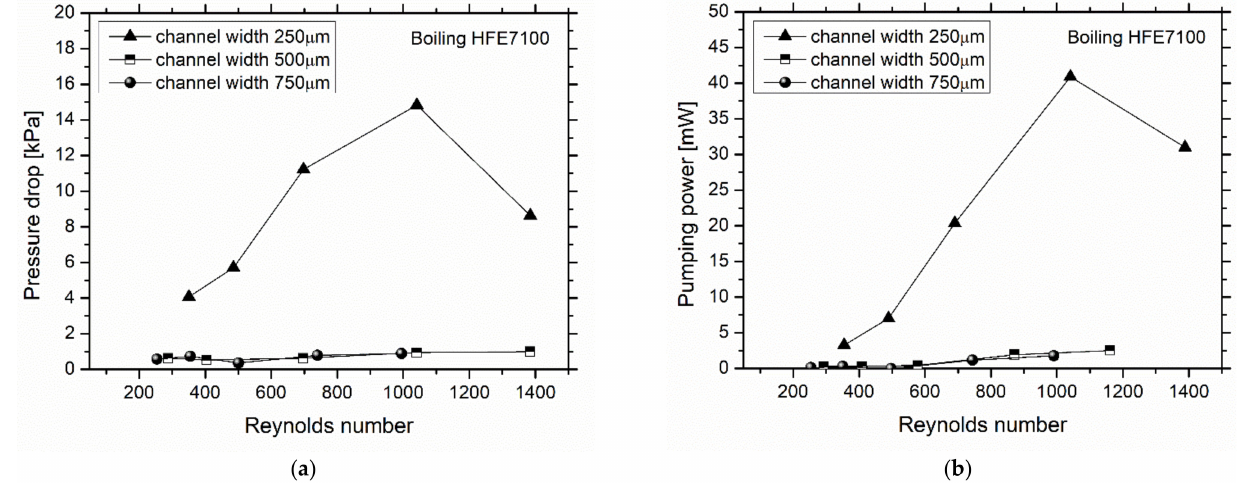
Figure 5. ( a ) Pressure drop and ( b ) pumping power of the boiling HFE7100 flow in the heat sinks with varying wall width.